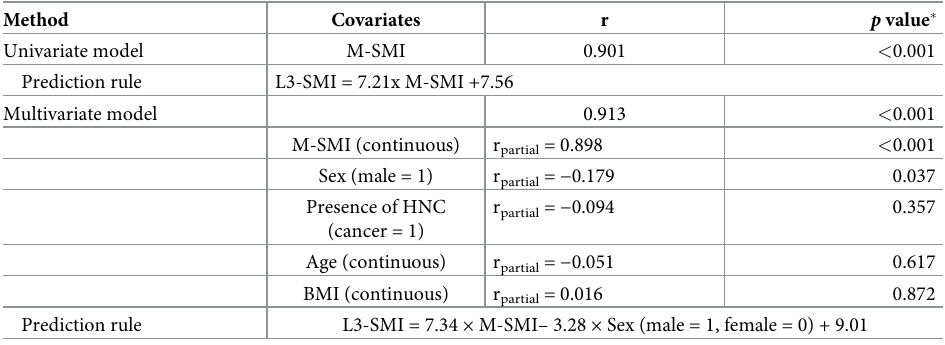
Table 3. Univariate and multivariate regression analysis.